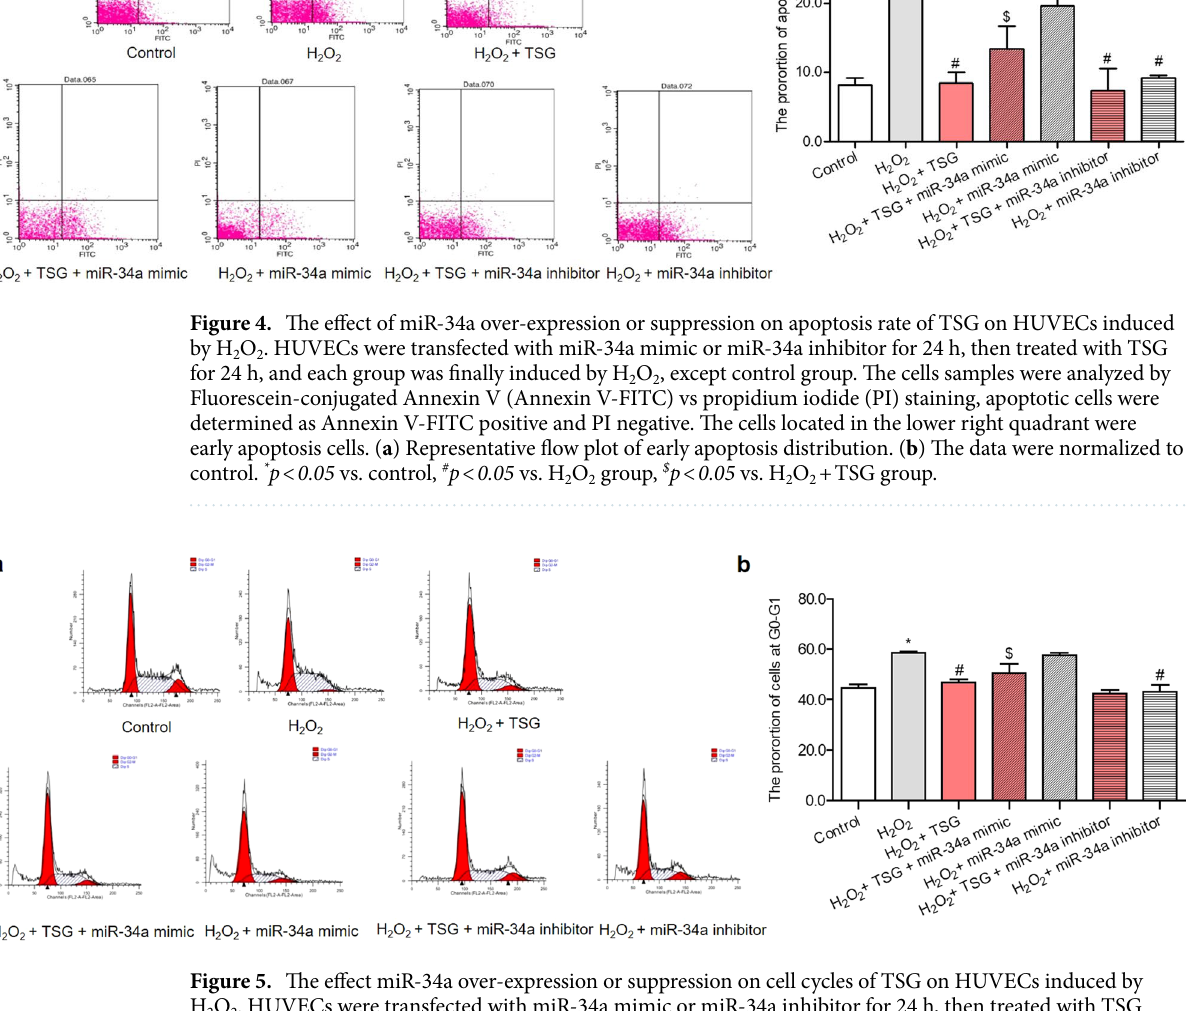
Figure 5. The effect miR-34a over-expression or suppression on cell cycles of TSG on HUVECs induced by H 2 O 2 . HUVECs were transfected with miR-34a mimic or miR-34a inhibitor for 24 h, then treated with TSG for 24 h, and each group was finally induced by H 2 O 2 , except control group. The cells samples were stained by PI staining, and flow cytometry analysis was used to detected the quantification of cell cycle proportion. ( a, b ) Representative flow plot of cell cycle distribution. * p < 0.05 vs. control, # p < 0.05 vs. H 2 O 2 group, $ p < 0.05 vs. H 2 O 2 + TSG